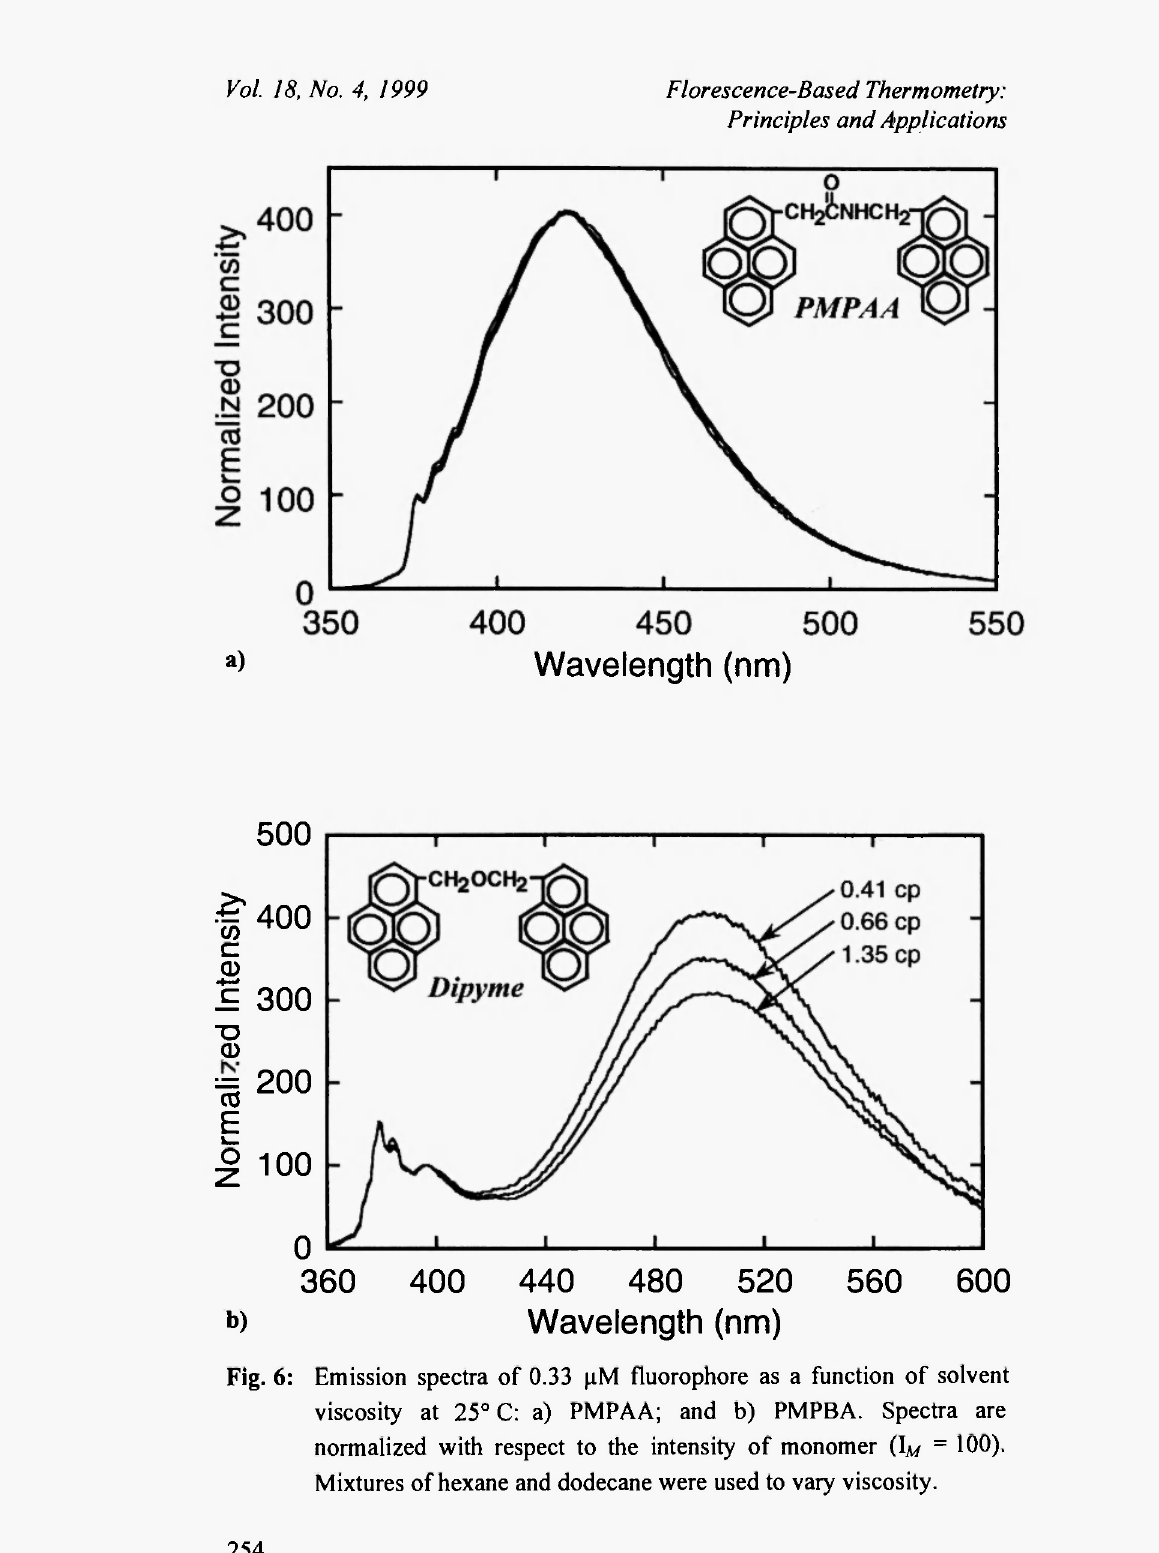
Fig. 6: Emission spectra of 0.33 μΜ fluorophore as a function of solvent viscosity at 25° C: a) PMPAA; and b) PMPBA. Spectra are normalized with respect to the intensity of monomer (l M = 100). Mixtures of hexane and dodecane were used to vary